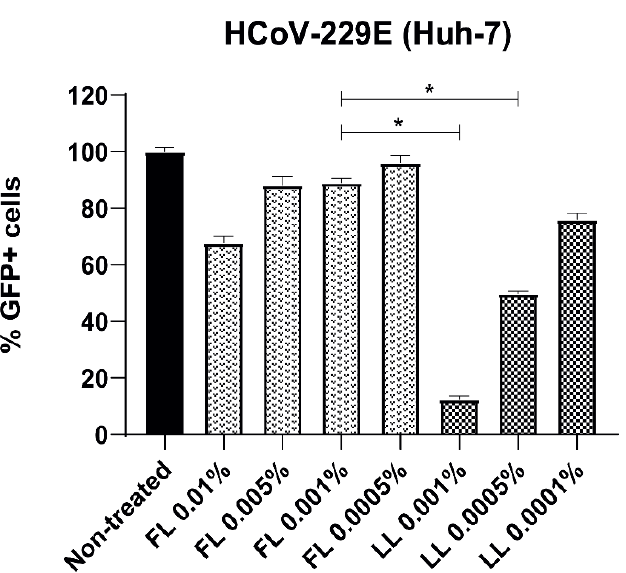
Figure 3. Comparison of the antiviral effect of free and liposomal bLf against HCoV229E in the Huh-7 cell line. Cells were incubated during all steps with either FL or LL at a specific range of concentrations and were subsequently infected with the corresponding virus at an MOI of 0.5. Columns represent the mean percentage of GFP+ cells compared to untreated cells. Triplicate experiments were performed for each data point ( n = 3), and the value is presented as mean percentage of infection/viability ± S.D. * p < 0.05 was considered statistically